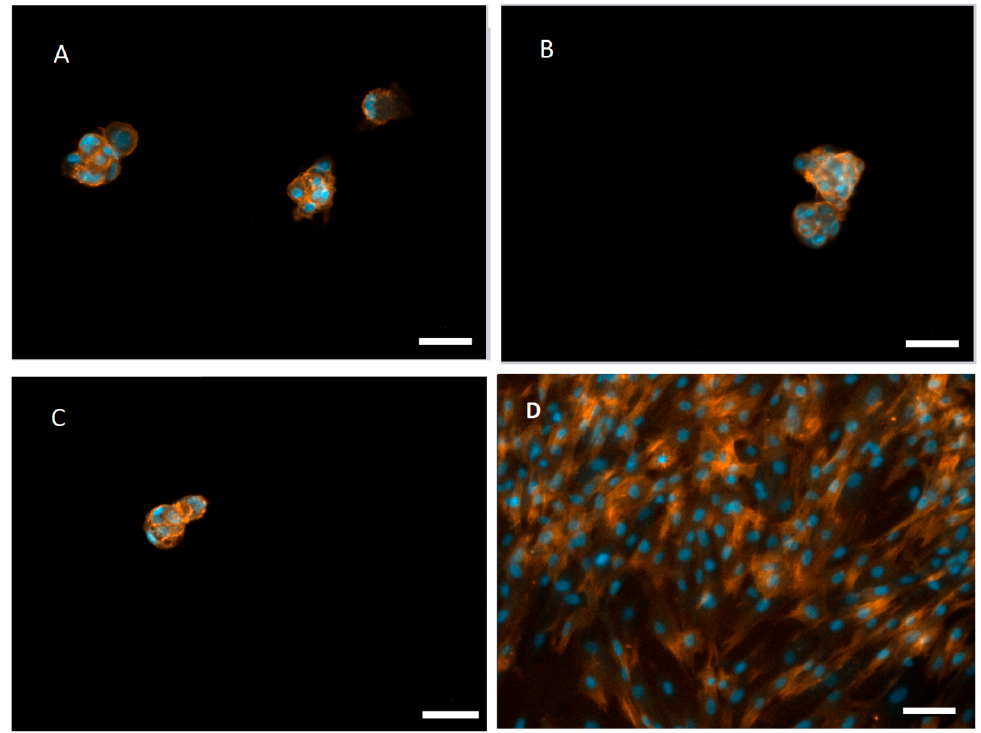
Figure 4. Representative fluorescence images of the hASCs cultured on top of normal–CHT/ALG ( A ); mesyl–CHT/ALG ( B ); tosyl–CHT/ALG ( C ); multilayered films and glass substrate ( D ). Multilayered films included subsequent layers of CHT and ALG with top layer (11th layer) was CHT. Scale bar: 200 µm. Cell nuclei appeared bright blue and F-actin filaments appeared bright red due to DAPI and phalloidin dyes, respectively.